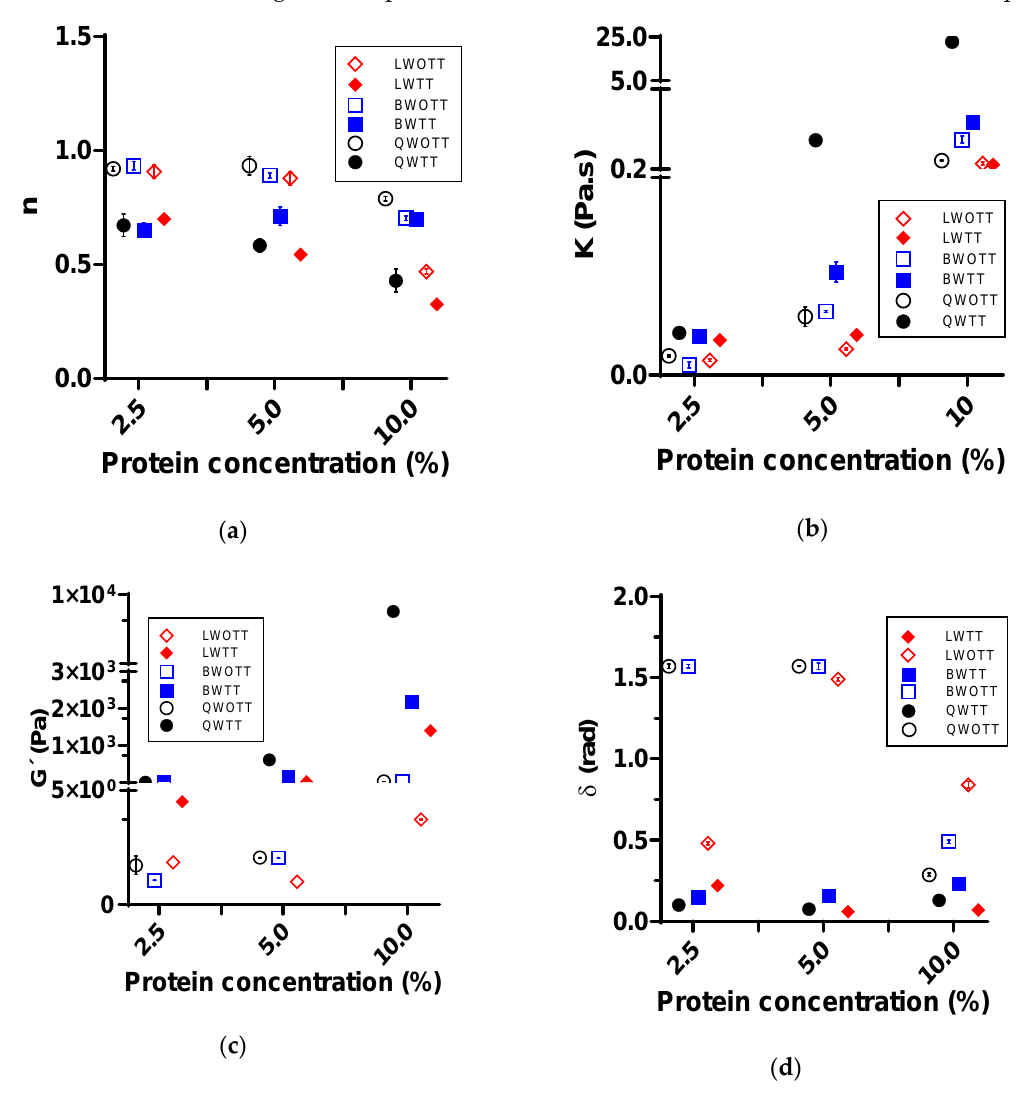
Figure 1. Effect of protein concentration and heat treatment on the rheological properties of solutions prepared with quinoa protein concentrates with heat treatment (QWTT) and without heat treatment (QWOTT); black bean protein concentrates with heat treatment (BWTT) and without heat treatment (BWOTT); and lentil protein concentrates with heat treatment (LWTT) and without heat treatment (LWOTT). ( a ) Average flow behavior ( n ); ( b ) average consistency index (K); ( c ) average storage module (G’) of the frequency sweeps; ( d ) average phase shift angle (δ) of the frequency sweeps.